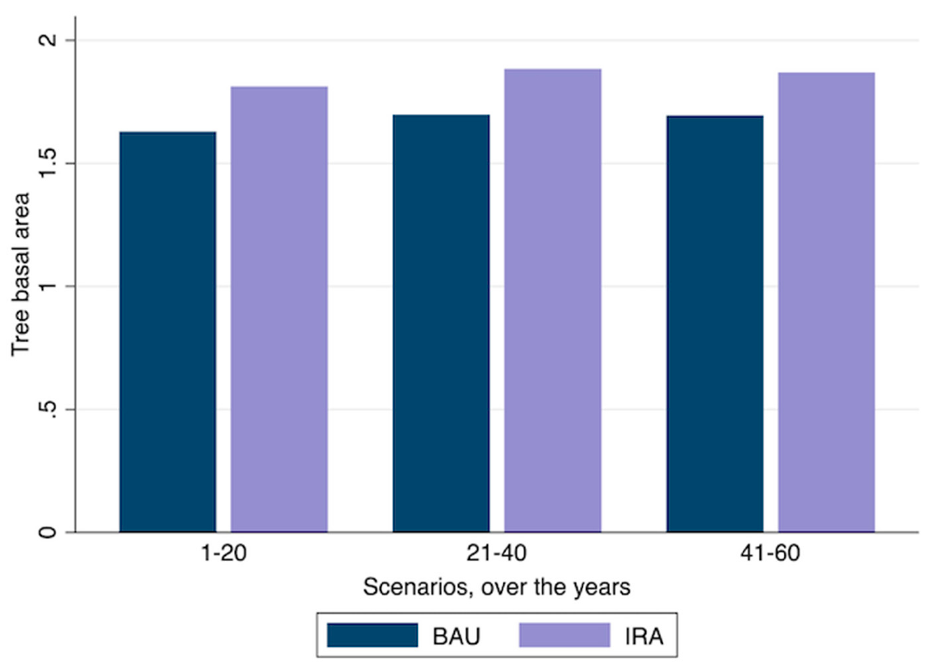
Figure A1. Simulation results: tree basal area over time.